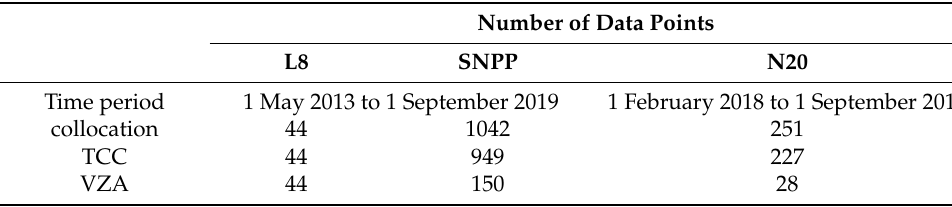
Table 2. The number of data points for each preprocessing